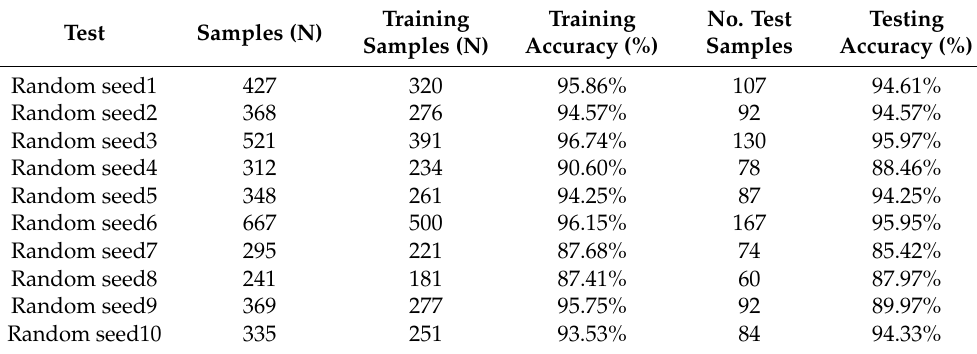
Table 5. Ten random tests of CRO-TWSVM with 5-fold cross-validation.